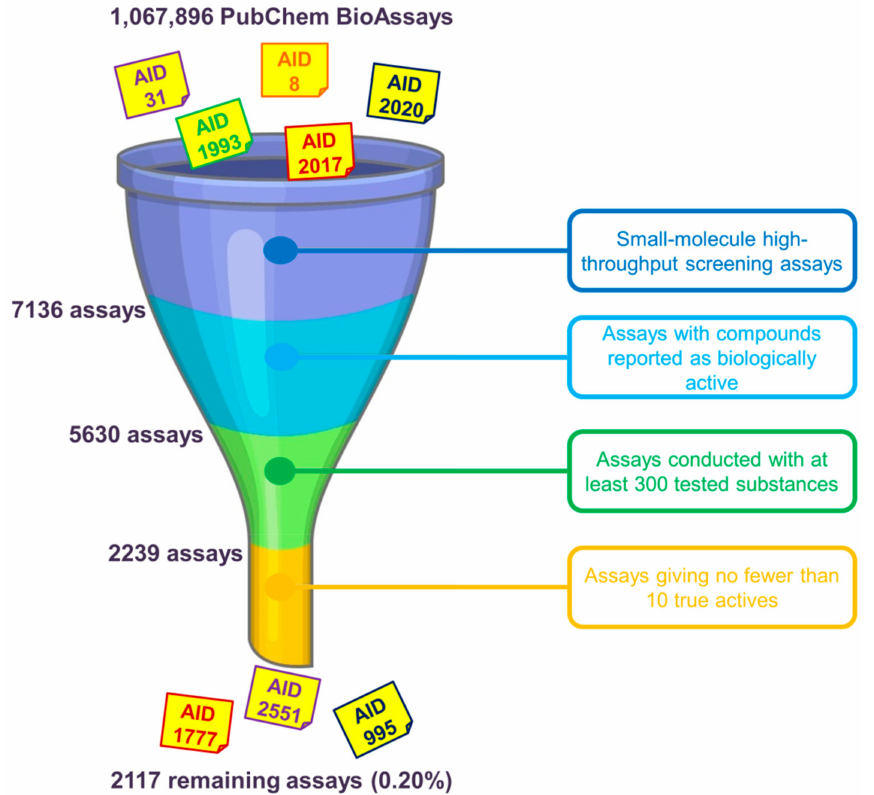
Figure 3. Primary selection of PubChem assays whose ligand sets should be further considered for evaluating virtual screening methods. We herewith recommend the use of only small-molecule high-throughput screening (HTS) assays giving at least 10 biologically active molecules among no fewer than 300 tested substances. Overall, there are only 2117 assays (0.20% of 1,067,896 assays in total, as of 30 April 2020) that remain, indicating a very small portion of PubChem assays that may be considered after this initial